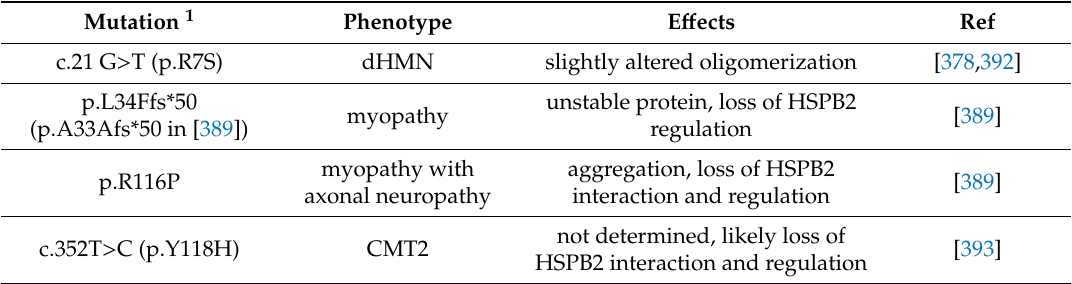
Table 7. HSPB3 mutations causing neuromuscular